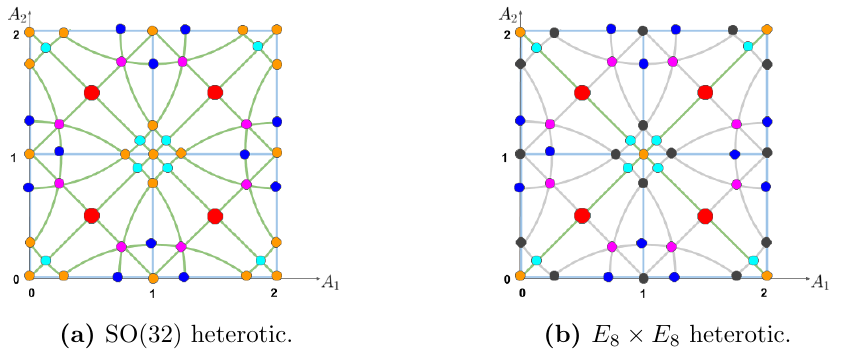
(a) SO(32) heterotic. Figure 5. Enhancement groups on the left sector of the heterotic theory on the slice of moduli space de(cid:12)ned by A 3 ;:::; 16 = 0, R 2 = 1 = 4. See table 3 for details.